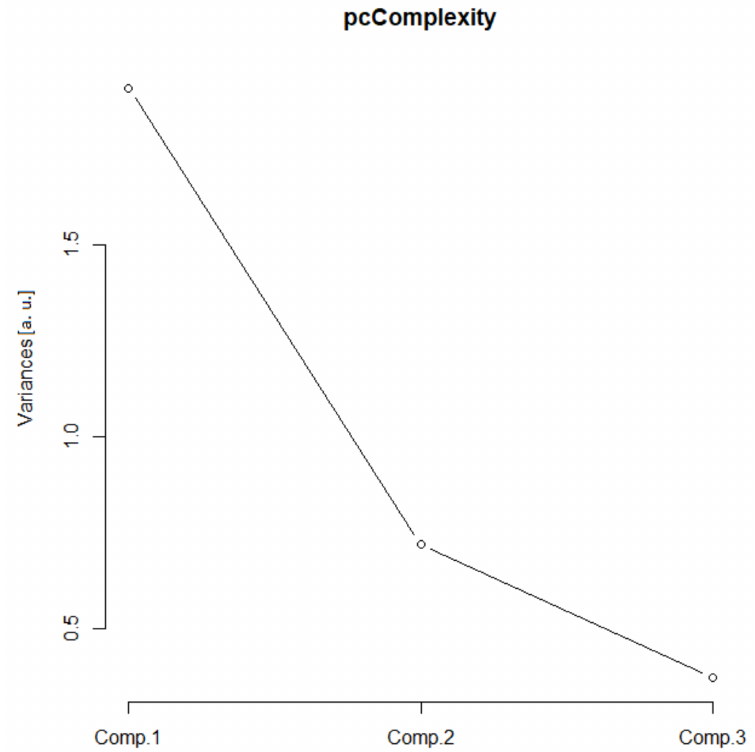
Figure 6. Complexity scree plot. The relationship between the variances (eigenvalues) and principal components for the complexity of the analyzed sample of astrocytes in the given group.